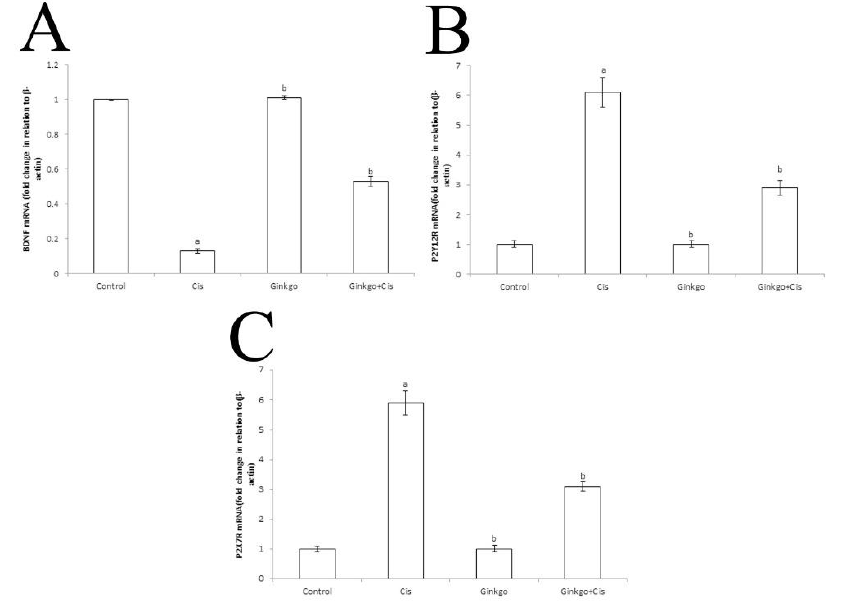
Figure 5. The changes of BDNF, P2Y12R and P2X7R mRNA expressions in different group. The Effect of Cis, Ginkgo , and their combination on the expression levels of BDNF ( A ), PY12R ( B ) and P2X7R ( C ) in rat brain tissues. Data were presented as mean ± SE ( n = 10). a indicates a significant difference compared to control group, b indicates a significant change compared to Cis group. a and b indicate statistical significance at p < 0.05 using ANOVA followed by Tukey–Kramer as a post ANOVA test.